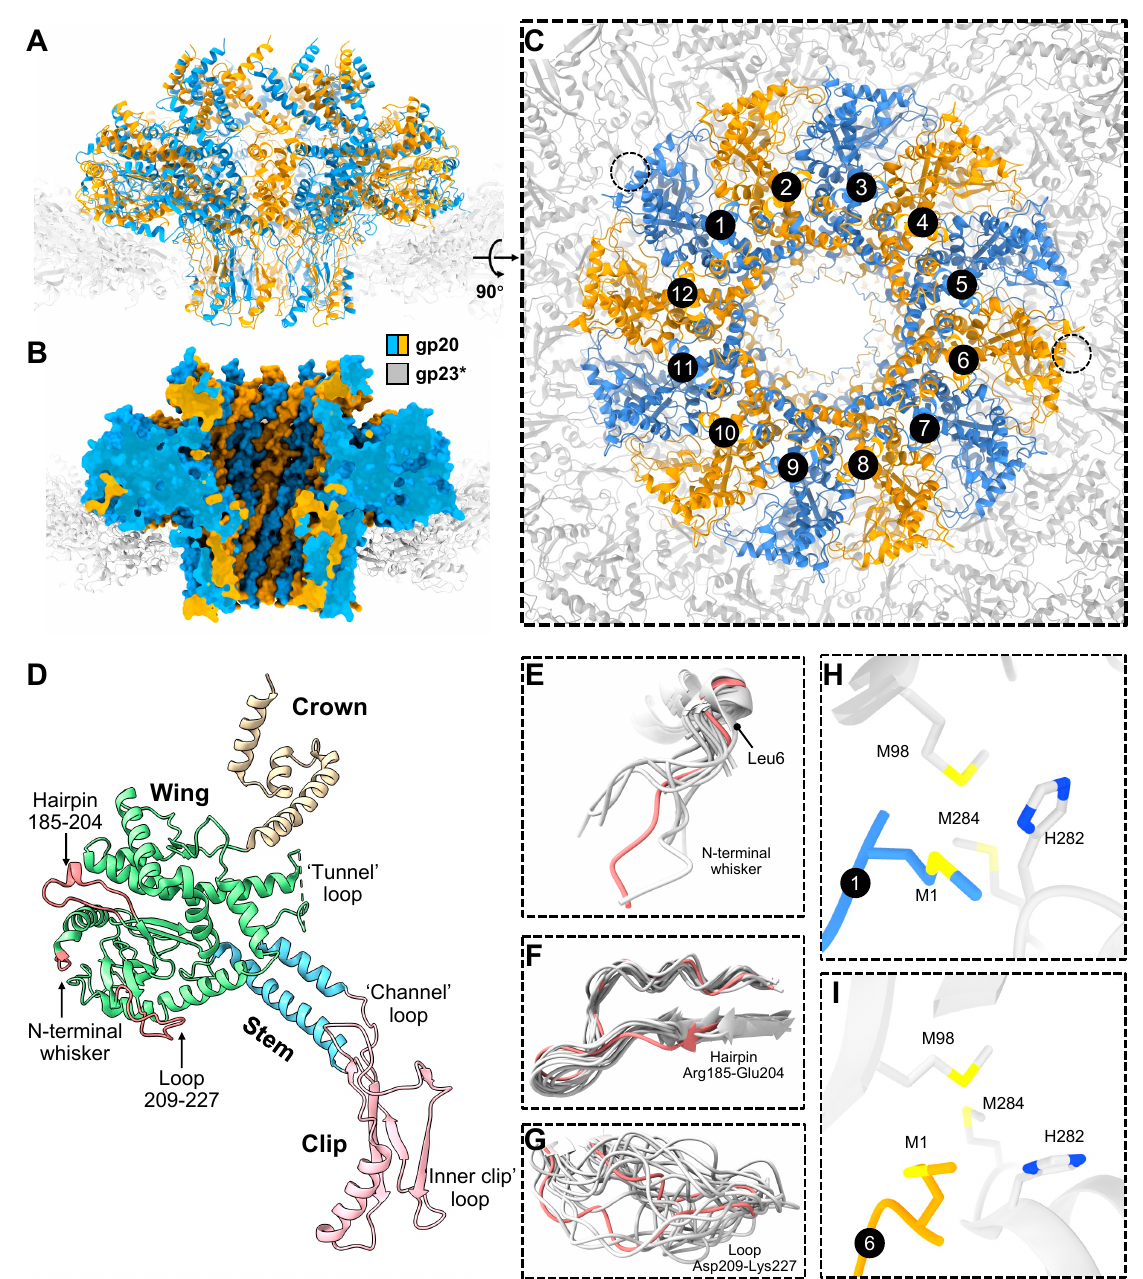
Figure 3. Structures of the portal protein gp20 and the symmetry-mismatched portal vertex. ( A – C ) Side views and top view of the portal protein assembly and its surrounding capsomers (PDB ID: 6UZC). The molecular surface of the portal protein assembly is shown in panel B to display the central channel. The 12 gp20 subunits are alternatively colored orange and blue and are labeled from 1 to 12 in panel ( C ). The gp23* subunits are colored gray. ( D ) Ribbon diagram of subunit 1, depicting the subdomains of the portal protein gp20. ( E – G ) Structural comparisons of the N-terminal whisker (panel ( E )), hairpin Arg185-Glu204 (panel ( F )), and loop Asp209-Lys227 (panel ( G )) among the 12 gp20 subunits within the portal protein assembly. ( H , I ) Enlarged views of circled regions in panel ( C ), showing the two potential metal clusters between gp20 subunit 1 and its neighboring gp23* subunits (panel ( H )) and between gp20 subunit 6 and its neighboring gp23*